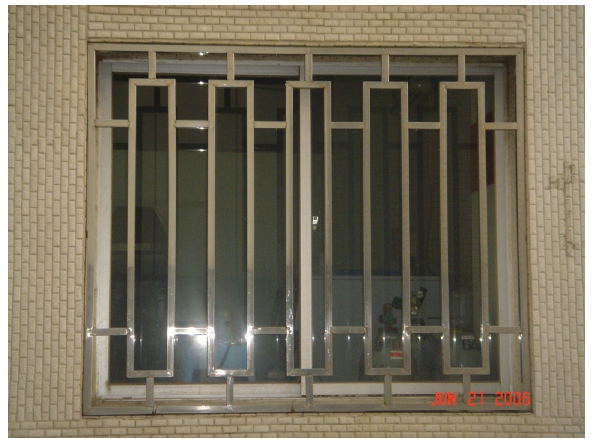
Figure 4. A typical window in Taiwan, with bars to enhance security.